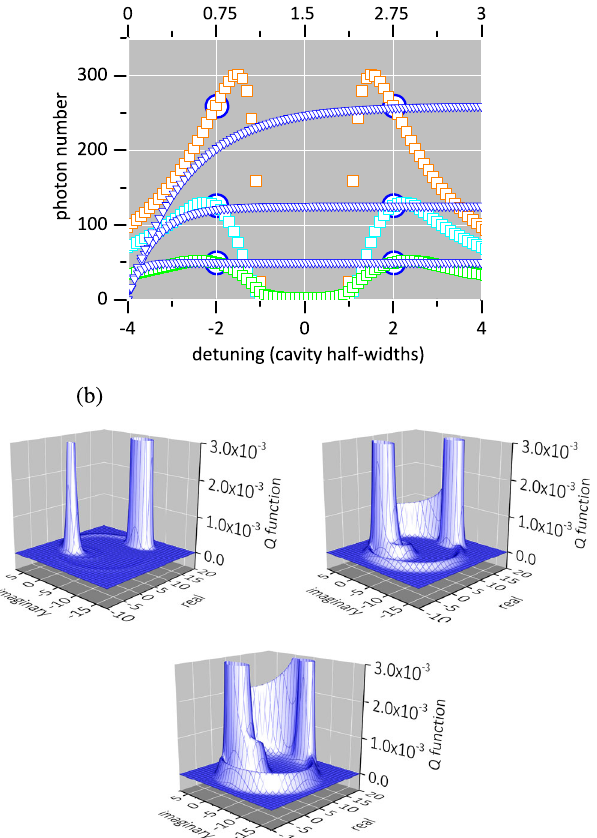
FIG. 6. (a) Mean photon number in the steady state versus detuning Δ ω = κ for drive amplitude E = κ ¼ 18 in Fig. 1 and spontaneous emission rate γ = κ ¼ 0 (orange), 0.1 (cyan), and 1 (green). Additional curves (blue triangles) show the time evolu- tion to steady state (blue circles) for Δ ω = κ ¼ (cid:2) 2 . 0 ; the time axis appears at the top of the graph. (b) Surface plot of the steady-state Q function for γ = κ ¼ 0 (upper left), 0.1 (upper right), and 1.0 0 . 006 ; 0 . 14 ; 0 . 19 ; right peak (lower); left peak heights h l ¼ 0 . 28 ; 0 . 12 ; 0 . 02 heights h r ¼